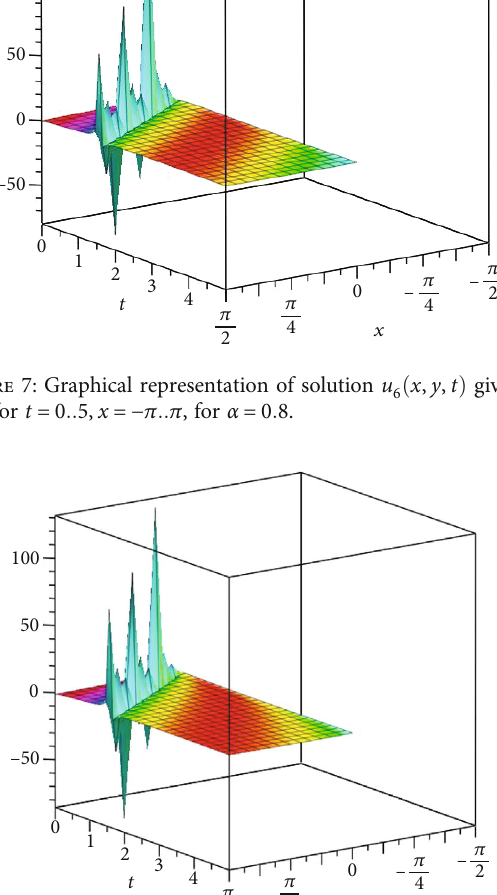
ð x , y , t Þ given by 6